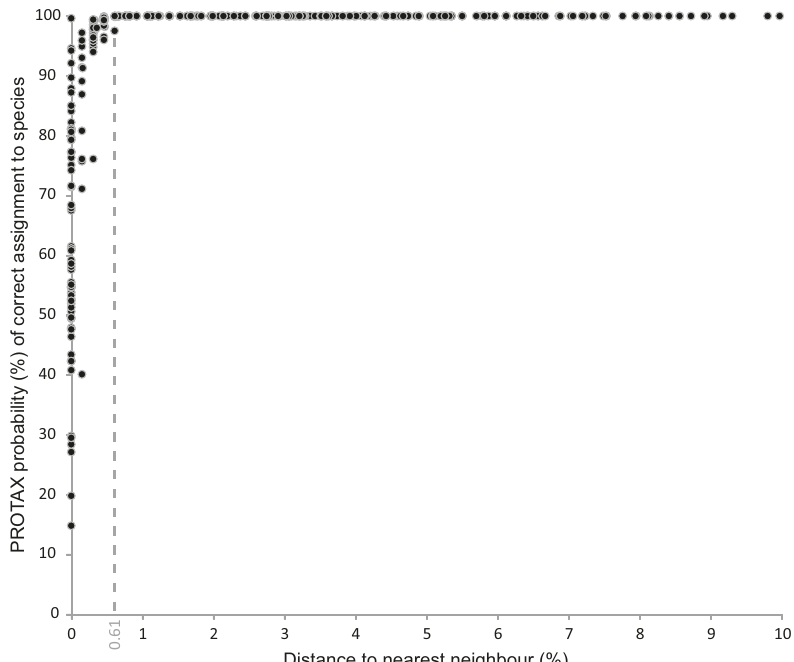
Fig. 4 Relationship between distances to nearest neighbour and PROTAX probabilities of correct assignment of specimens to species. Distances to nearest neighbour represent the minimum genetic distance between specimens of a given species from any other species in the dataset ( x -axis). PROTAX probabilities of correct assignment to species ( y -axis), represent the average probability for each species ( n = 451